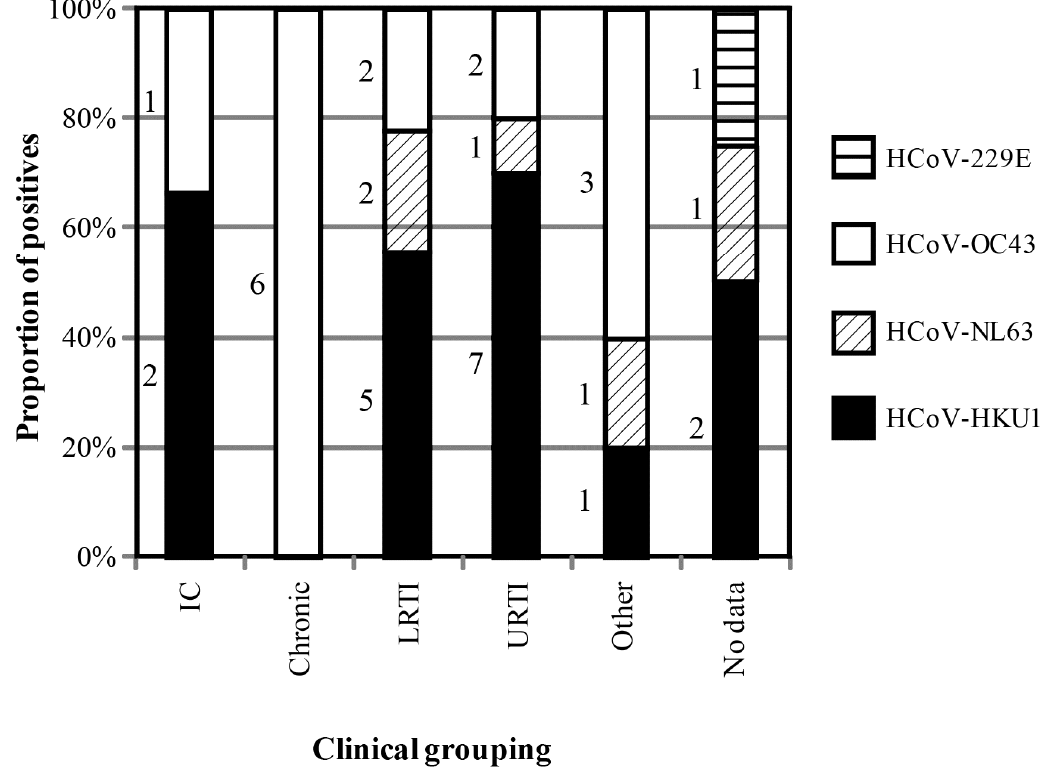
Figure 3. Clinical groupings among the single detection of each HCoV. Based on the criteria of Gaunt et al. [19]. The number of HCoV detections is shown to the left of each bar. IC-immunocompromised; LRTI-lower respiratory tract illness; URTI-upper respiratory tract